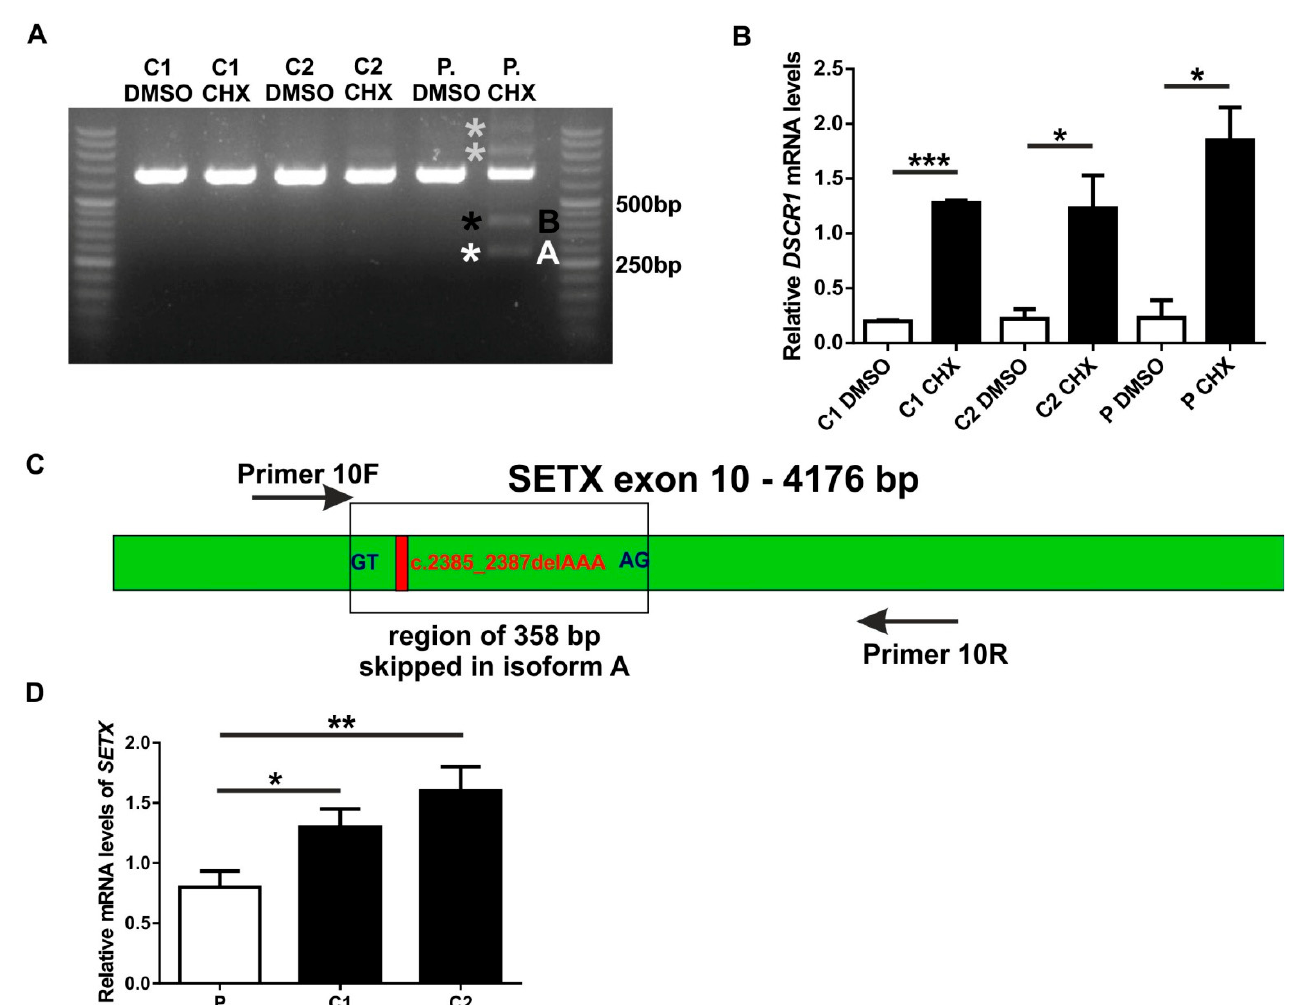
Figure 2. ( A ). Visualization of cDNA analysis on agarose gel. Fibroblasts from the patient (P) and controls (C1, C2) were treated with DMSO (lines 1,3,5) or cycloheximide (CHX) (line 2,4,6) for 10 h to block nonsense-mediated decay. White asterisk indicates aberrant isoform (*A) with partial skipping (358 bp) of SETX exon 10 in the patient’s fibroblasts, arising due to the presence of variant c.2385_2387delAAA, as evidenced by sequencing of band A (see Figure S4). Sequencing of the excised band *B (Figure 2A, lane 6) revealed that it is an artifact; ( B ) mRNA transcribed from DSCR1 gene (the Down syndrome critical region 1), a known NMD target, was used as a positive control to confirm NMD inhibition; ( C ) schematic representation of SETX exon 10, black empty square denotes 358 bp sequence skipped from exon 10 carrying c.2385_2387delAAA variant. Black arrows correspond to primers used for isoform analysis; ( D ) real-time PCR demonstrated lower levels of SETX mRNA in the patient compared to healthy controls (Table S4, Scheme S1). P was calculated in two-tailed t -test, * p < 0.05, ** p < 0.01, *** p < 0.001.